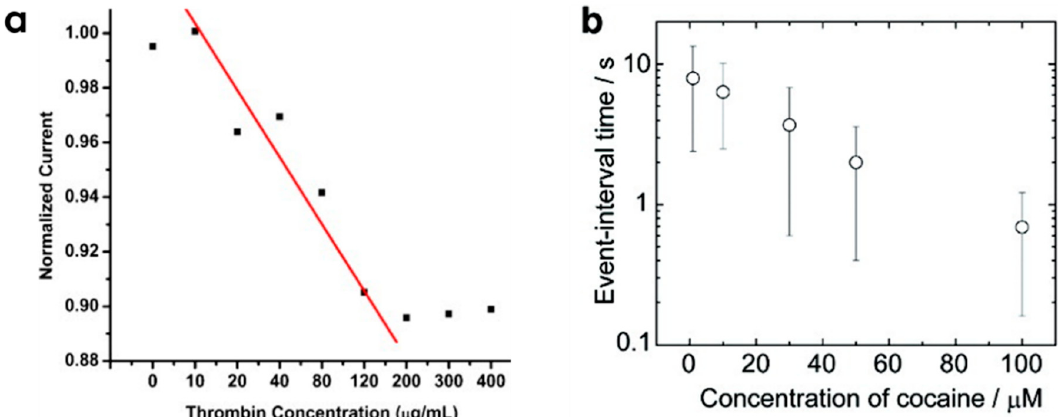
Figure 9. ( a ) Calibration curve of a protein (thrombin) quantification based on the normalized current from nanopipette sensing. Reprinted adapted with permission from [90]. ( b ) Calibration curve of a small molecule (cocaine) from the blocking time by the aptamer bound cocaine. Reprinted adapted with permission from [156]. Copyright 2011 American Chemical Society.